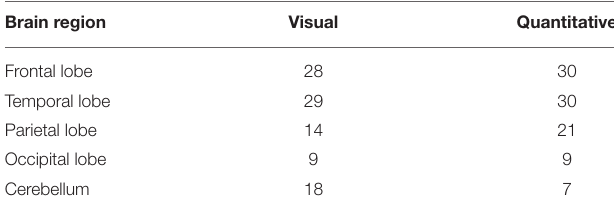
TABLE 2 | Comparison of visual and quantitative SPECT interpretations of hypoperfused brain